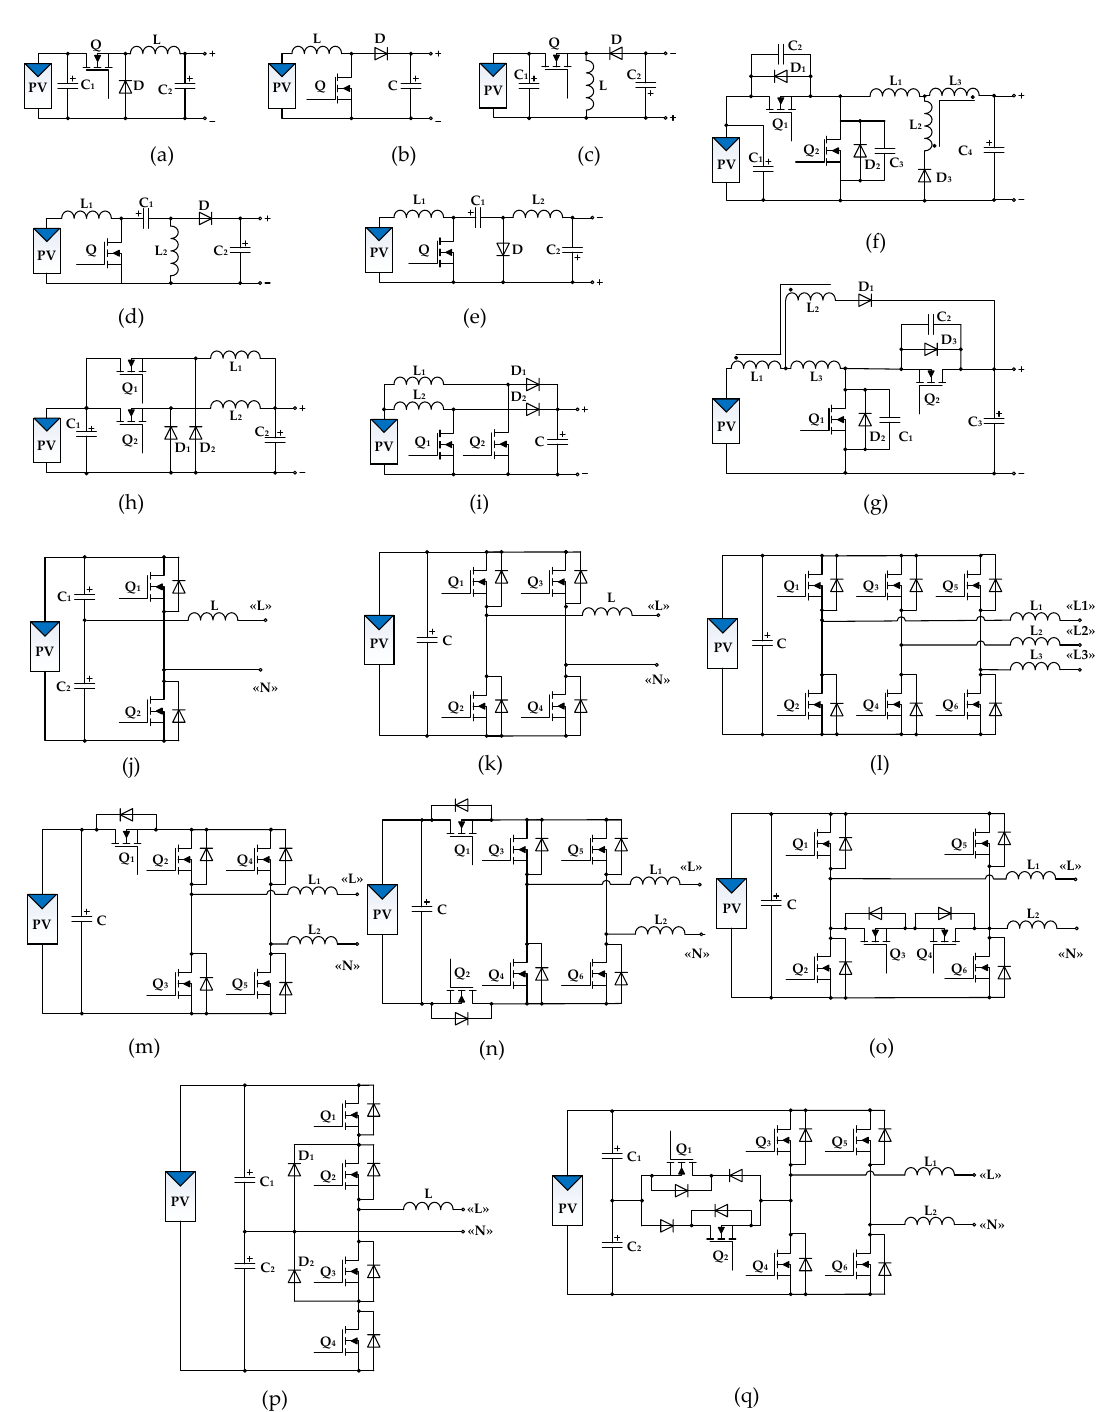
Figure 9. Converter topologies for grid-based applications: ( a ) buck; ( b ) boost; ( c ) buck-boost; ( d ) SEPIC; ( e ) Cuk’; ( f ) soft-switching buck; ( g ) soft-switching boost; ( h ) interleaved buck; ( i ) interleaved boost; ( j ) half-bridge; ( k ) full-bridge; ( l ) three phase full-bridge; ( m ) H5; ( n ) H6; ( o ) HERIC; ( p ) 3L-NPC; ( q ) 3L-SC.